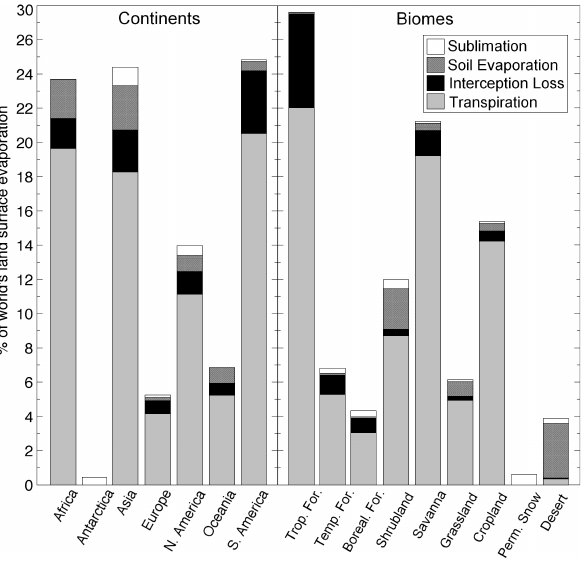
Fig. 6. Contribution to global land-surface evaporation (in %) for each: (a) continent, and (b) biome type. The relative contribution of the constituents of evaporation is presented